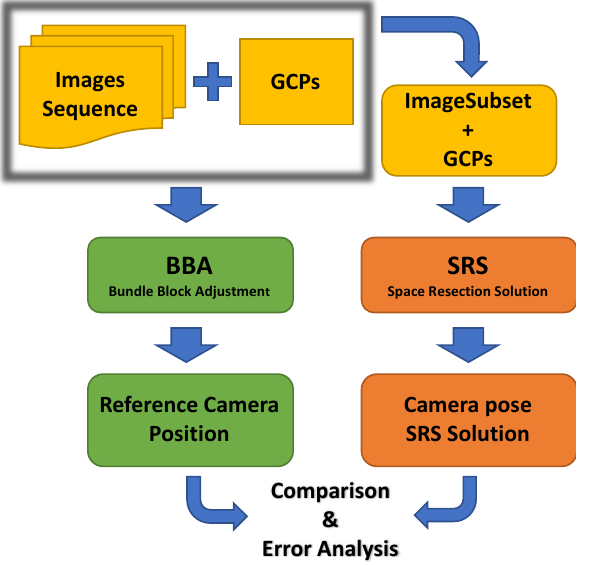
Figure 2. Designed system architecture to determine error analysis of SRS results.